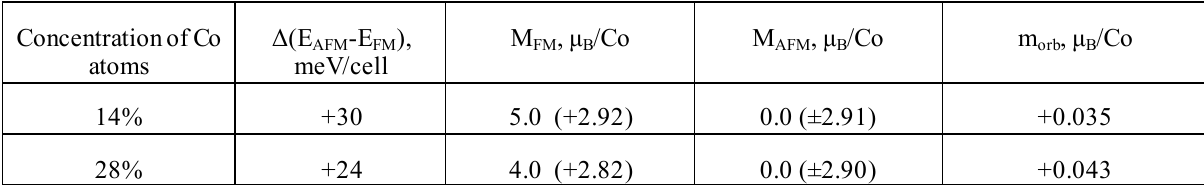
Table 1. The AFM and FM energy differences (Δ(E AFM -E FM )) , total (M FM , M AFM ) and local (in parentheses) spin magnetic moments in FM and AFM phases, m orb is the orbital magnetic moment in FM phase.